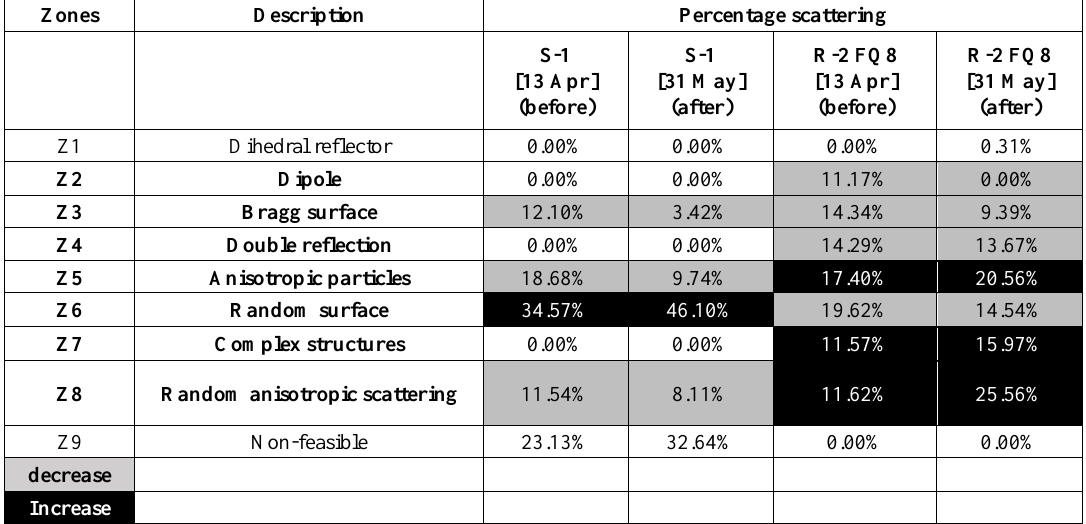
Table 3. Percentage scattering in each zone from before and after lodging image pairs derived using same date Sentinel-1 and high incidence angle RADARSAT-2 FQ21